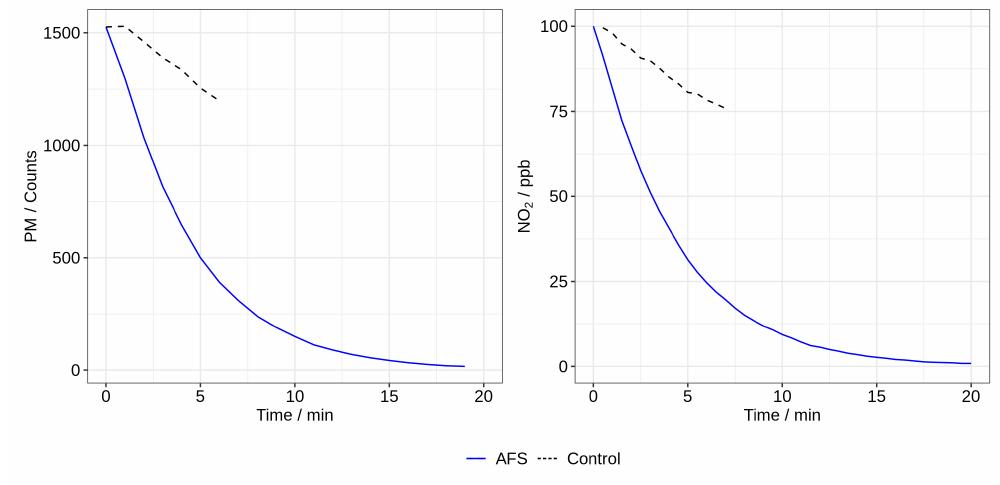
Figure 2. PM with a diameter of 0.3 µ m ( left ) and NO 2 ( right ) removal by the Air Filtration System (AFS) over time in a 2 m 3 chamber (solid blue line), and control (dashed black line).